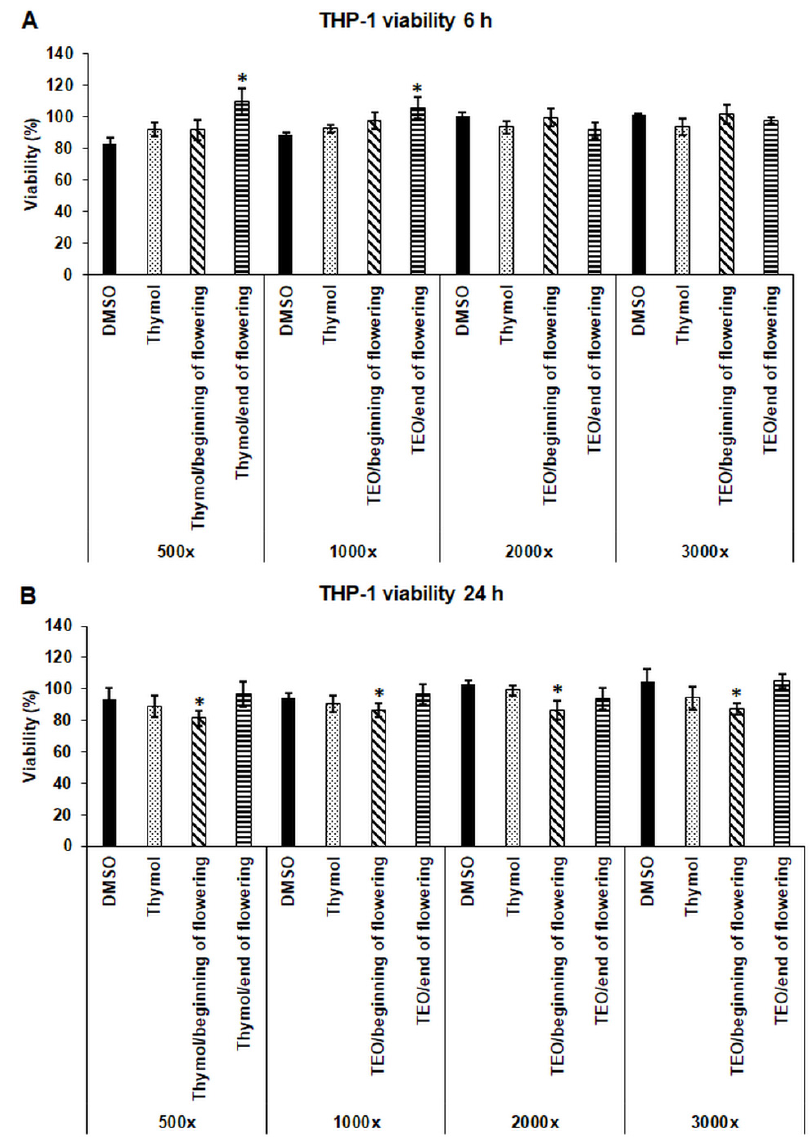
Figure 1. Determination of the viability of THP-1 cells treated with thymol and TEOs. Viability of the THP-1 cells was measured using CCK-8 cell viability assay after 6 h ( A ) and 24 h ( B ) treatments using serial dilutions of the stock solutions of DMSO, thymol, and TEOs. Viability is expressed as percentile of the untreated cells. The bars represent mean values, and error bars represent standard deviation (SD) for four independent experiments (n = 4). Cell viability assays were carried out in quadruplicate in each experiment. Asterisks indicate p < 0.05 compared to the DMSO-treated cells. Statistical analysis was carried out by two-way ANOVA followed by Scheffe’s post hoc test.